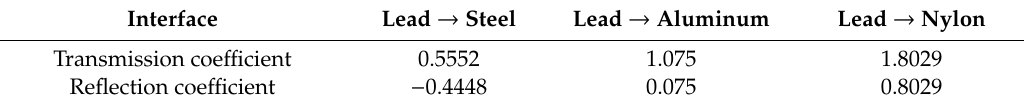
Table 7. Transmission and reflection coe ffi cients between lead specimen and output bar.